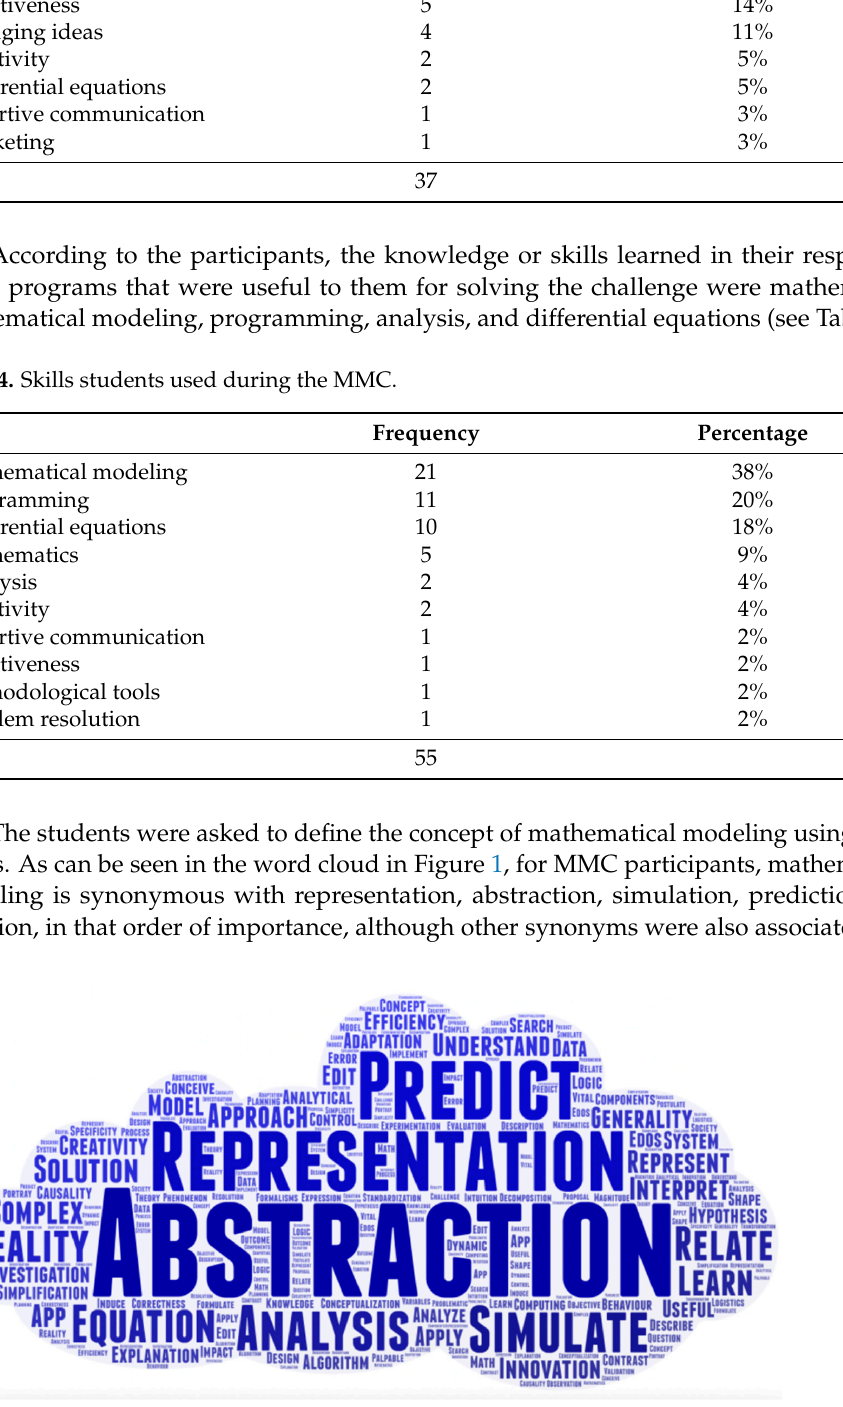
Figure 1. The main words that students associate with mathematical